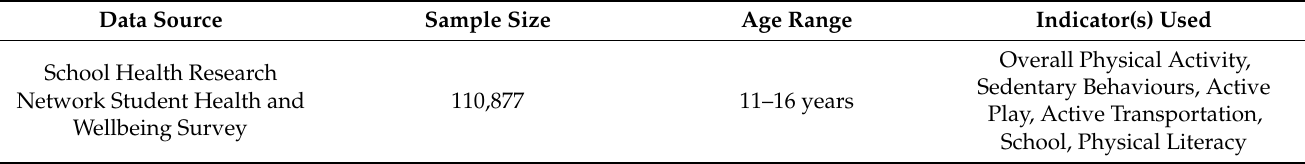
Table 3. The characteristics of the data sources and the quality indicators these sources